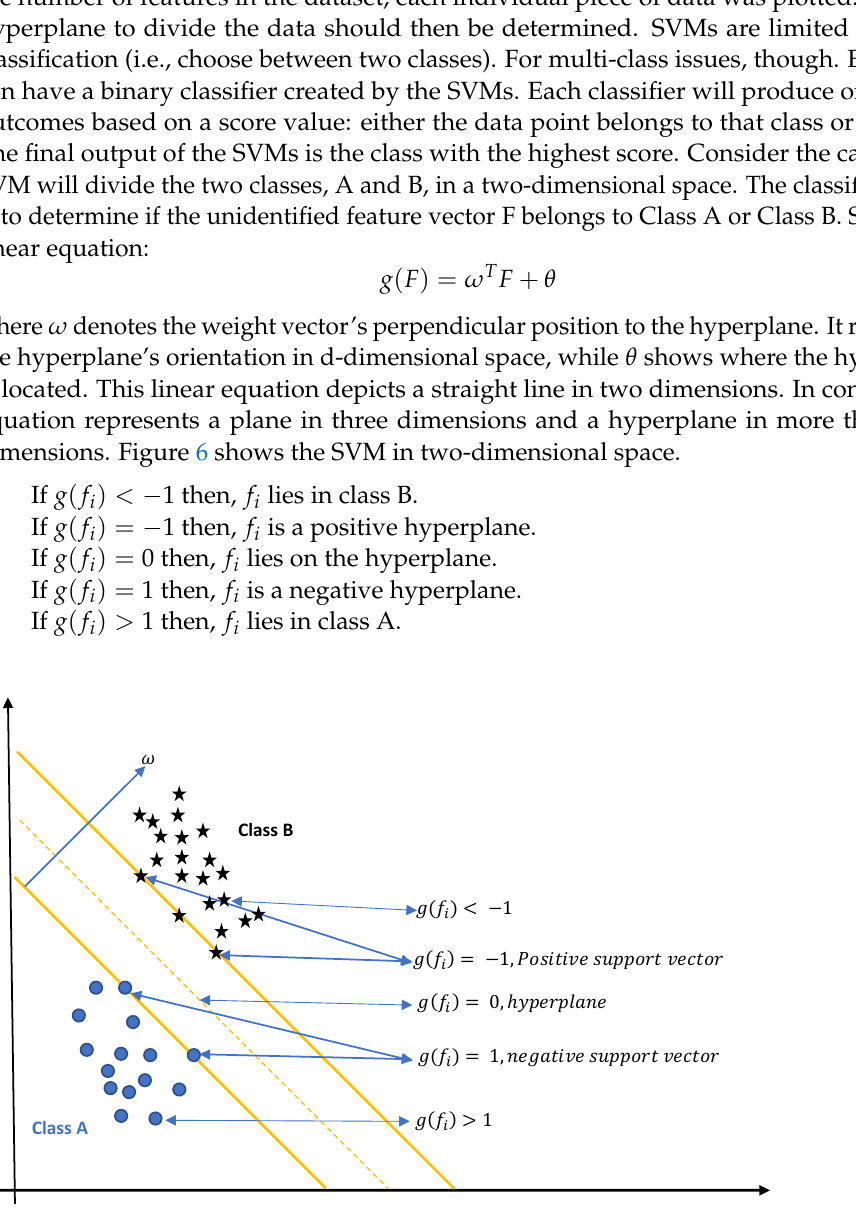
Figure 6. SVMs maximize the hyperplane between two different classes, A and